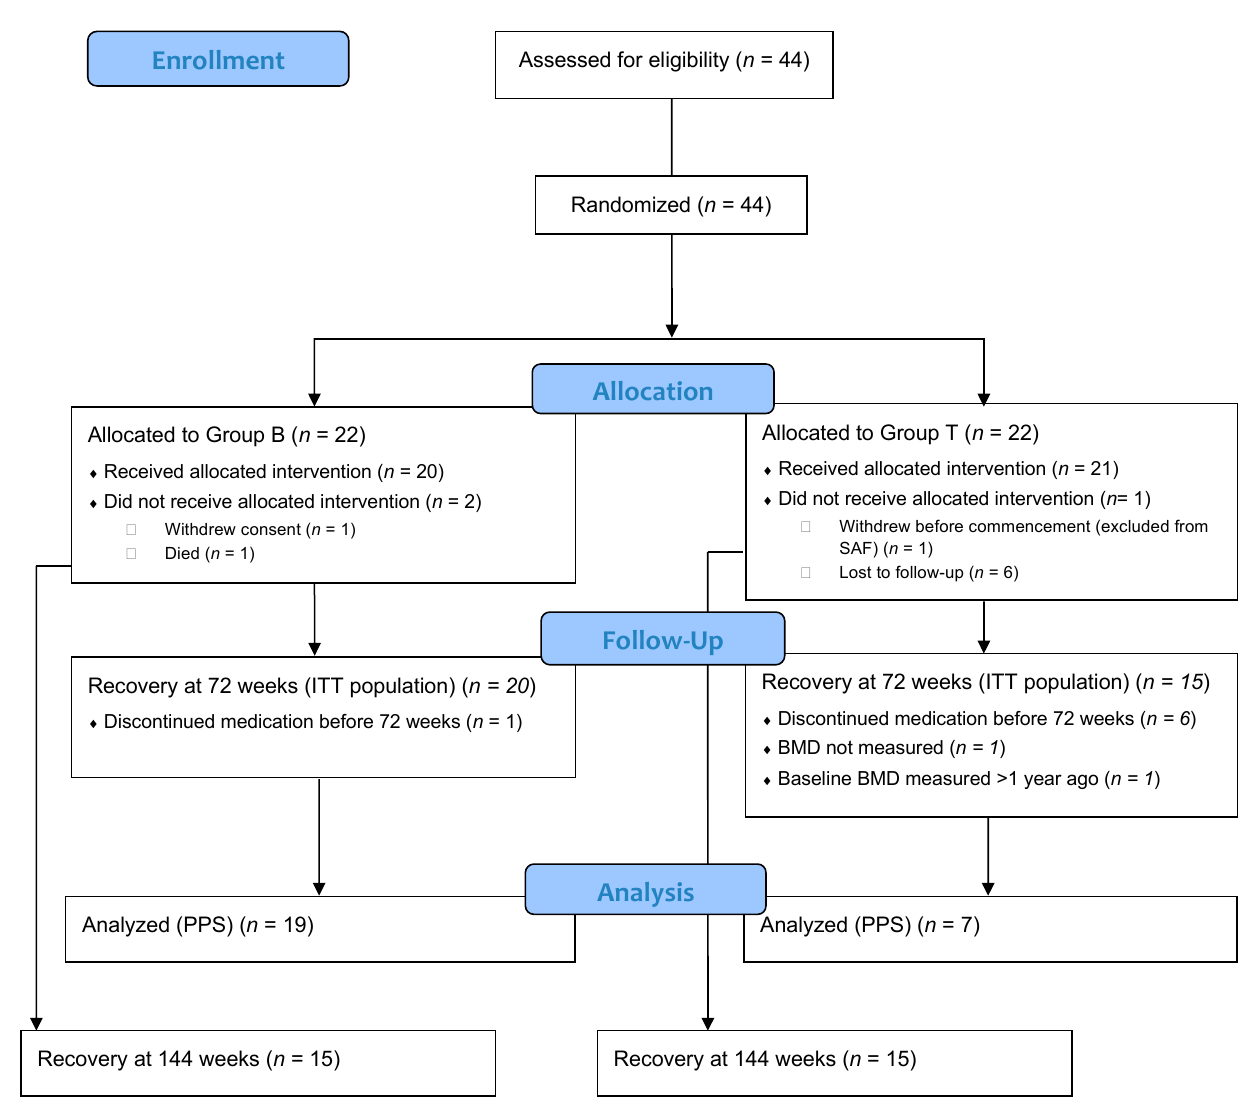
Figure 1. Patient disposition. Group B, bisphosphonate group; Group T, teriparatide group; ITT, intention ‐ to ‐ treat; PPS, per ‐ protocol population; SAF, safety analysis set.